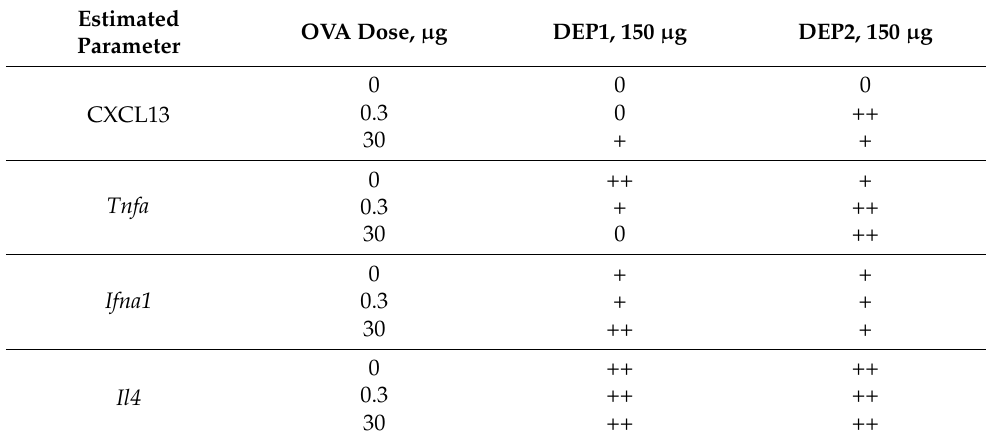
Table 3. The effect of DEPs on CXCL13 production, proinflammatory cytokines, and the expression of B-cell-activation markers in the lung tissue and regional lymph nodes of immunized mice in comparison with those in mice immunized without DEPs with the indicated OVA doses.